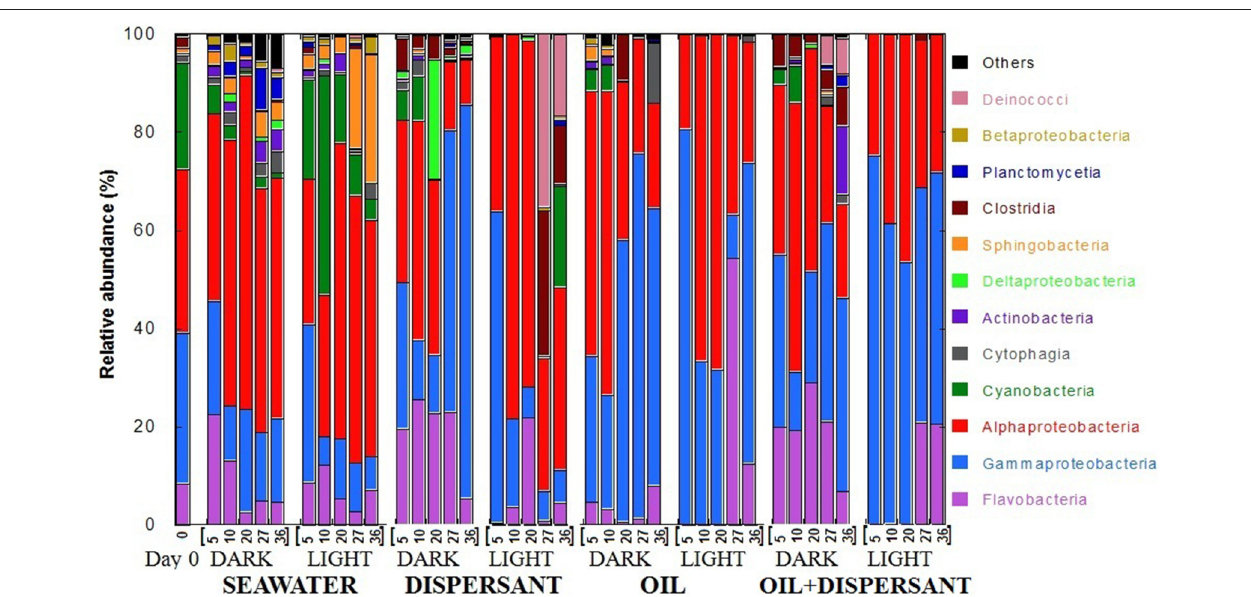
FIGURE 2 | Relative abundances of bacteria at class level in seawater alone, seawater with dispersant Corexit, crude oil, and both oil and dispersant incubated under the dark and light conditions for 36 days. The numbers on the horizontal axis indicate the days of incubation.